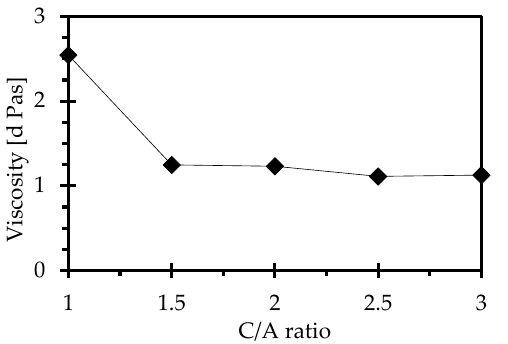
Figure 14. Effect of C/A ratio on viscosity measured by the IPT method.